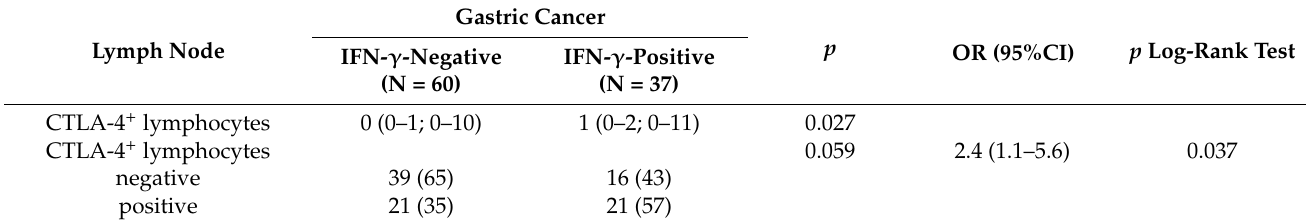
Table 4. Correlation of IFN- γ in tumors with CTLA-4 lymphocytes in gastric cancer.